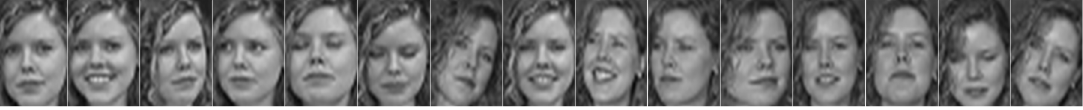
10 of 18 Figure 2. Average recognition rate versus reduce dimensions on ORL dataset. ( a ) l = 4, ( b ) l = 5, ( c ) l = 6, and ( d ) l = 7. We list the computational time (in seconds) of each method for one run with different values of training samples  , shown in Table 2. As can be seen from the time results that the time taken by proposed method is slightly more than the other methods and the difference is not much. This is because of one more loop added in our algorithm. However, the performance of the WNPEE is superior to the other algorithms. Table 2. Computation time on ORL face database under different trains for one run (time in seconds). No. of Trains